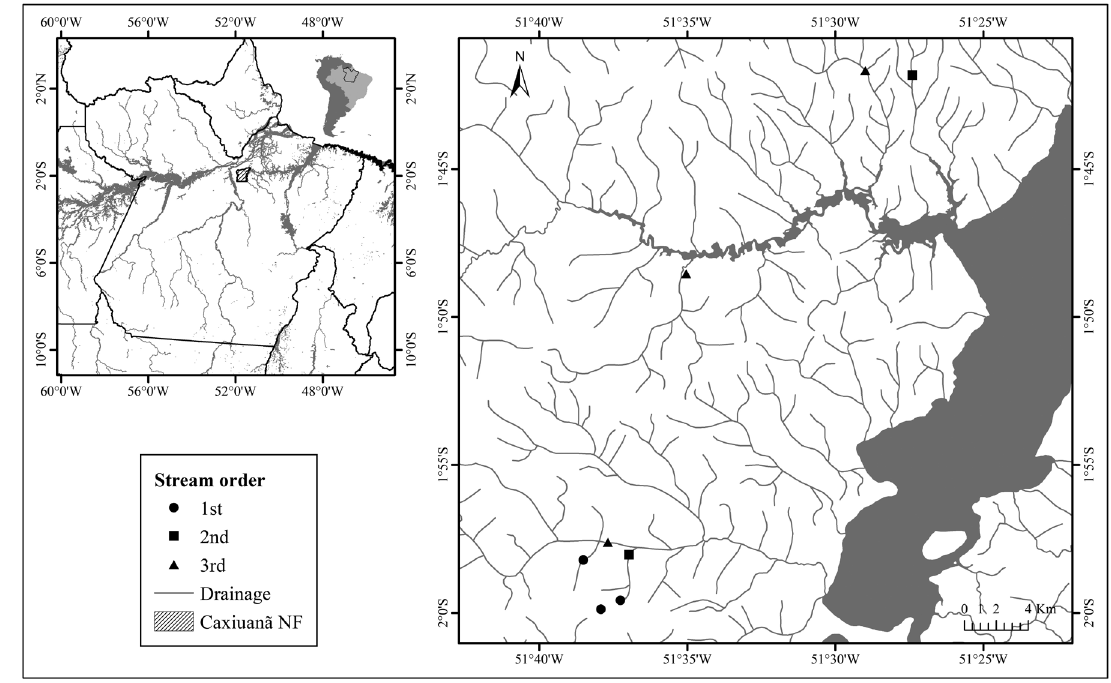
FIGURE 1 | Streams sampled during the dry period of 2010 and the flood period of 2011 in the Caxiuanã National Forest, Eastern Amazon, State of Pará,